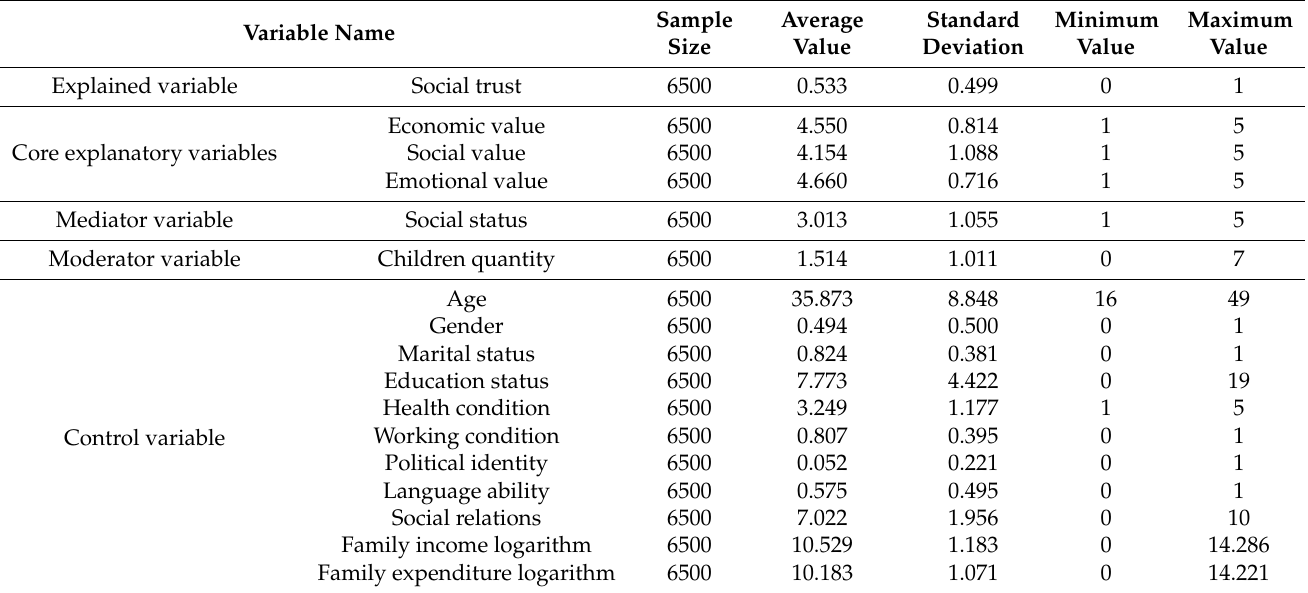
Table 1. Descriptive statistics of the